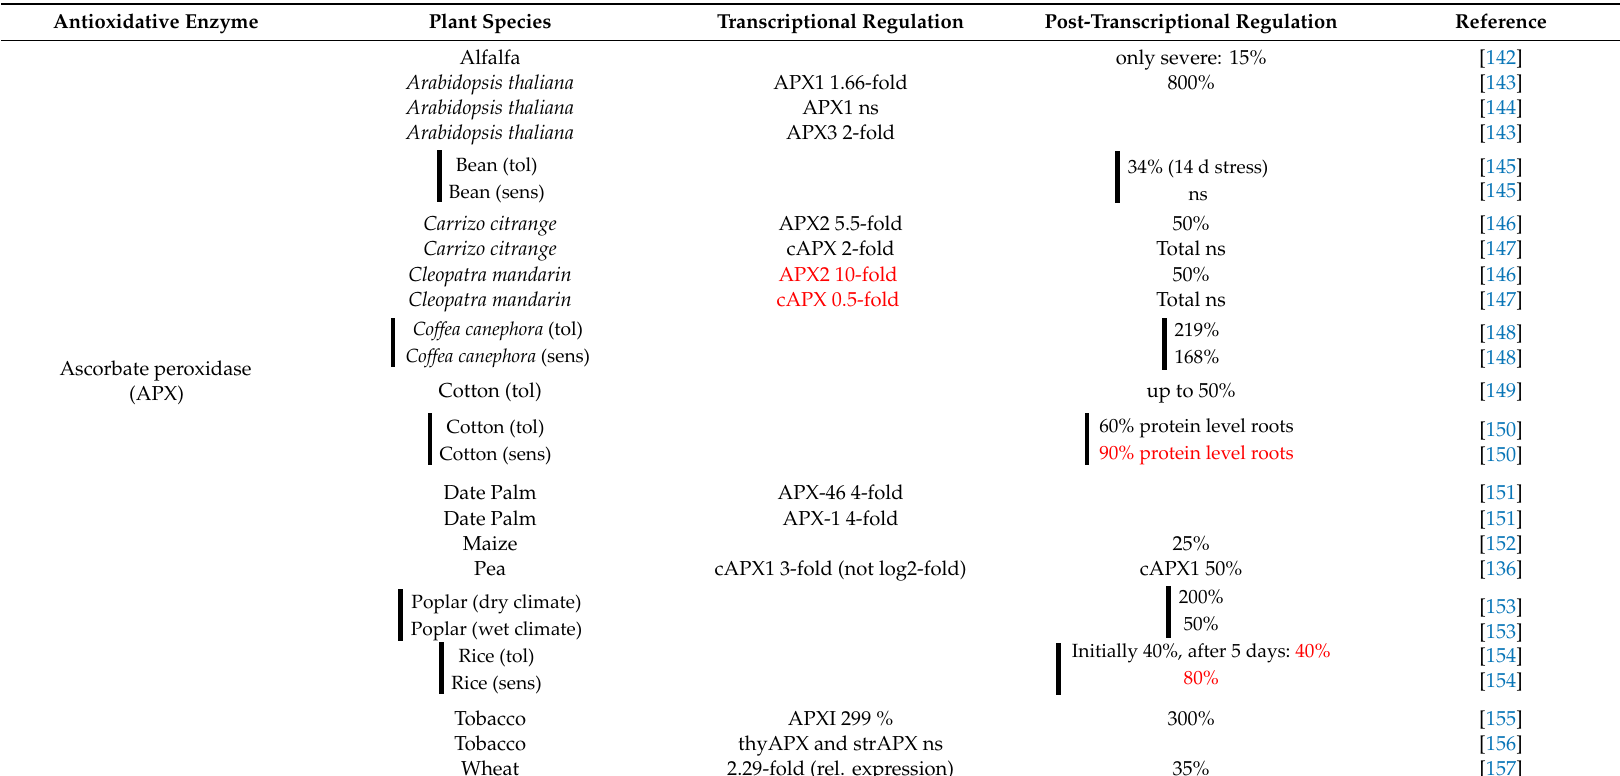
Table 4. Antioxidant enzymes regulated in plants under drought.